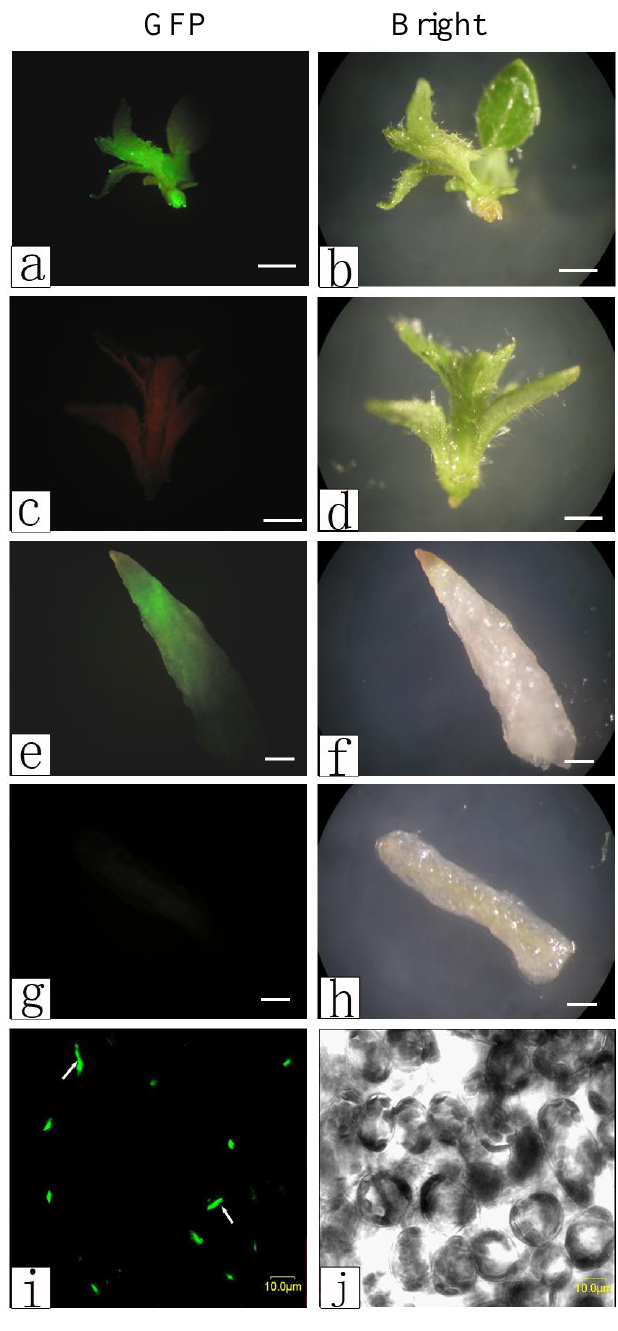
Figure 6. Expression of the MD–GFP fusion protein in transgenic poplar. Non-transgenic with no GFP signal in poplar shoots ( c ) and ( d ) and roots ( g ) and ( h ). GFP fluorescence in the shoots ( a ) and ( b ), roots ( e ) and ( f ), and leaf epidermis ( i ) and ( j ) of transgenics. Left column was the GFP fluorescence images and right column was the optical images. Scale bar ( a – h ) 0.2 cm; ( i – j ) 10 μm.